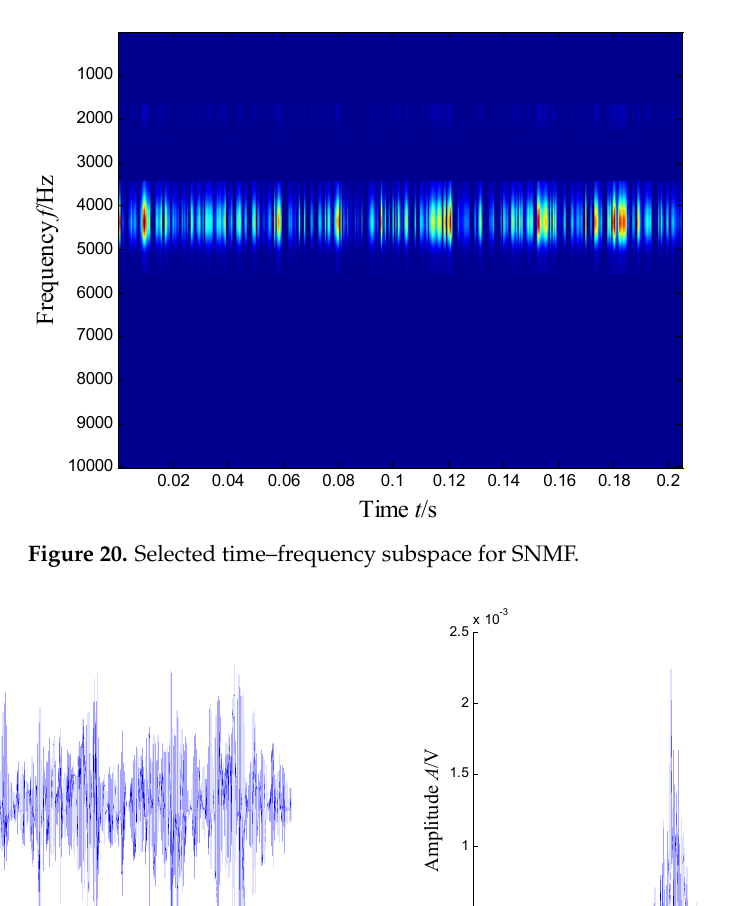
Figure 19. Coefficient matrix obtained by SNMF.